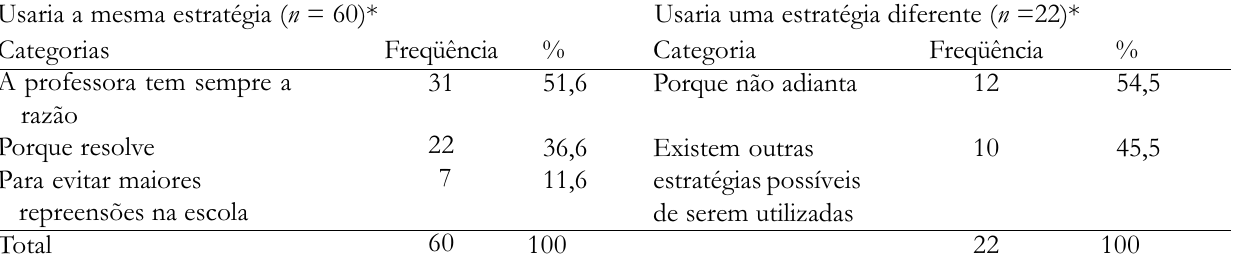
Freq(cid:252)Œncias e Percentagens das Categorias Identificadas a partir das Justificativas sobre a Auto-Avalia(cid:231)ªo das Crian(cid:231)as das suas EstratØgias de Coping Relacionadas aos Problemas com a Professora